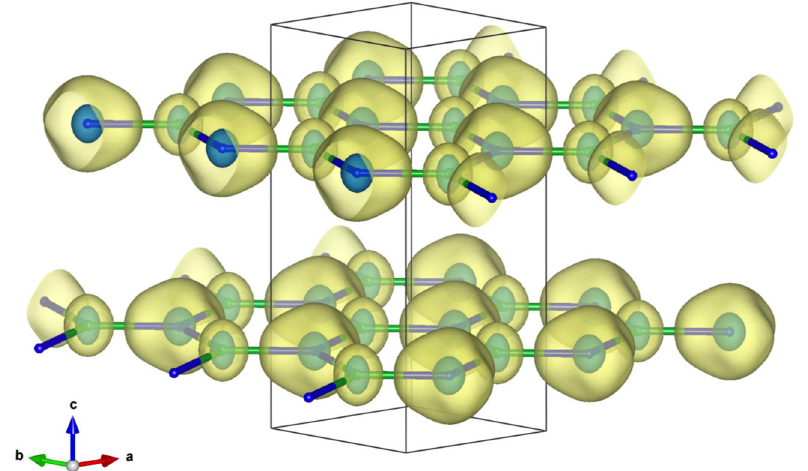
Figure 3: The side view (view orthogonal to c-axis)oftheelectrondensityrevealstheAA ′ stacking of h-BN. This projection is obtained from the X-ray diffraction pattern using the maximum entropy method. Reproduction of figure S7 of reference